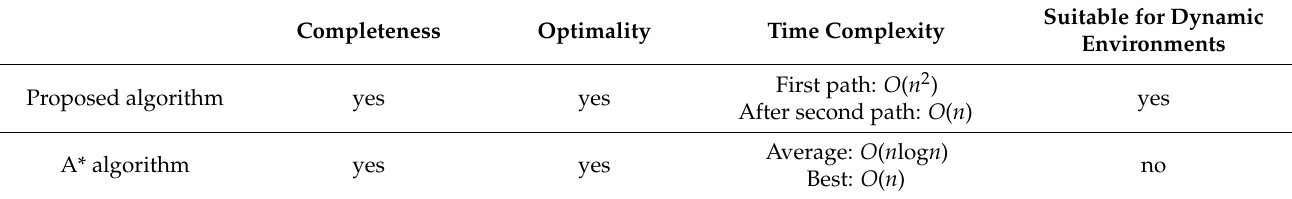
Table 1. Algorithm analysis between the proposed and A* algorithm.